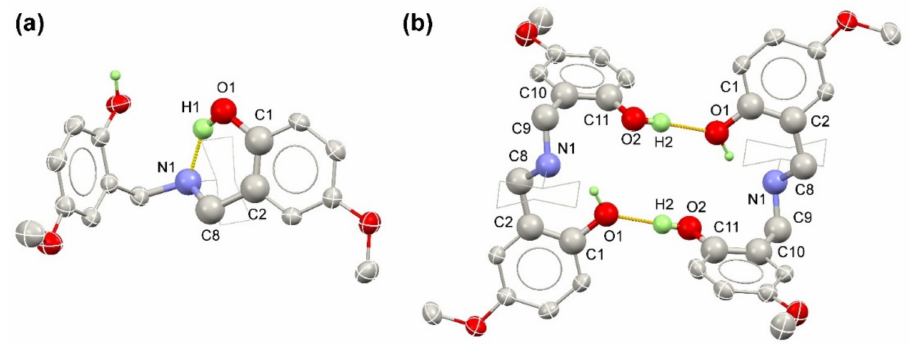
Figure 3. ( a ) The intramolecular S (6) O–H ··· N hydrogen bonding and ( b ) the intermolecular R 22 (20) O–H ··· O hydrogen bonding. The atoms regarding the H-bond motifs are displayed in ball-and-stick style, while other atoms are drawn as displacement ellipsoids with 30% probability